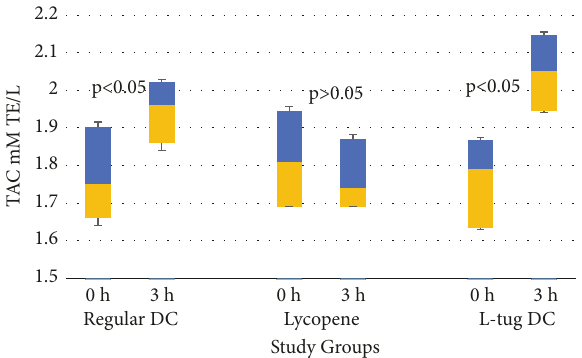
Figure 5: Box-and-whisker analysis. Postprandial changes in total antioxidant capacity of serum in volunteers following ingestion of L-tug DC. “ p ” values reflect intragroup differences between initial and final